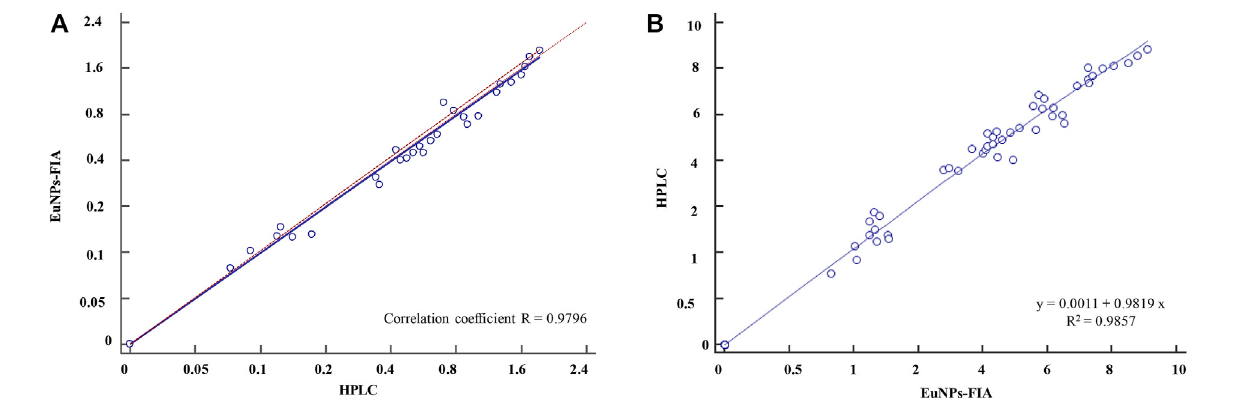
FIGURE 6 | Comparison of EuNPs-FIA and HPLC. (A) Comparative method scatter diagram of EuNPs-FIA and HPLC. (B) Passing-Bablok regression.